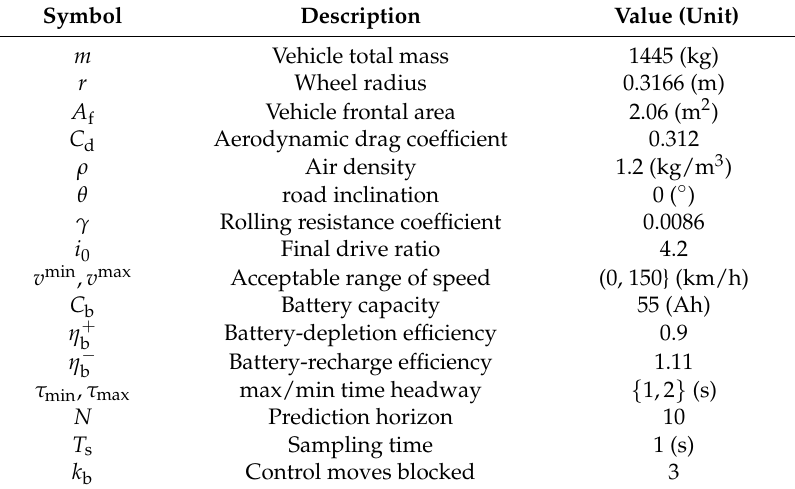
Table 3. Simulation